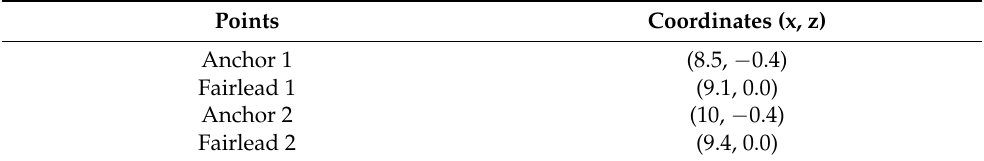
Table 2. Locations of the fairleads and anchor